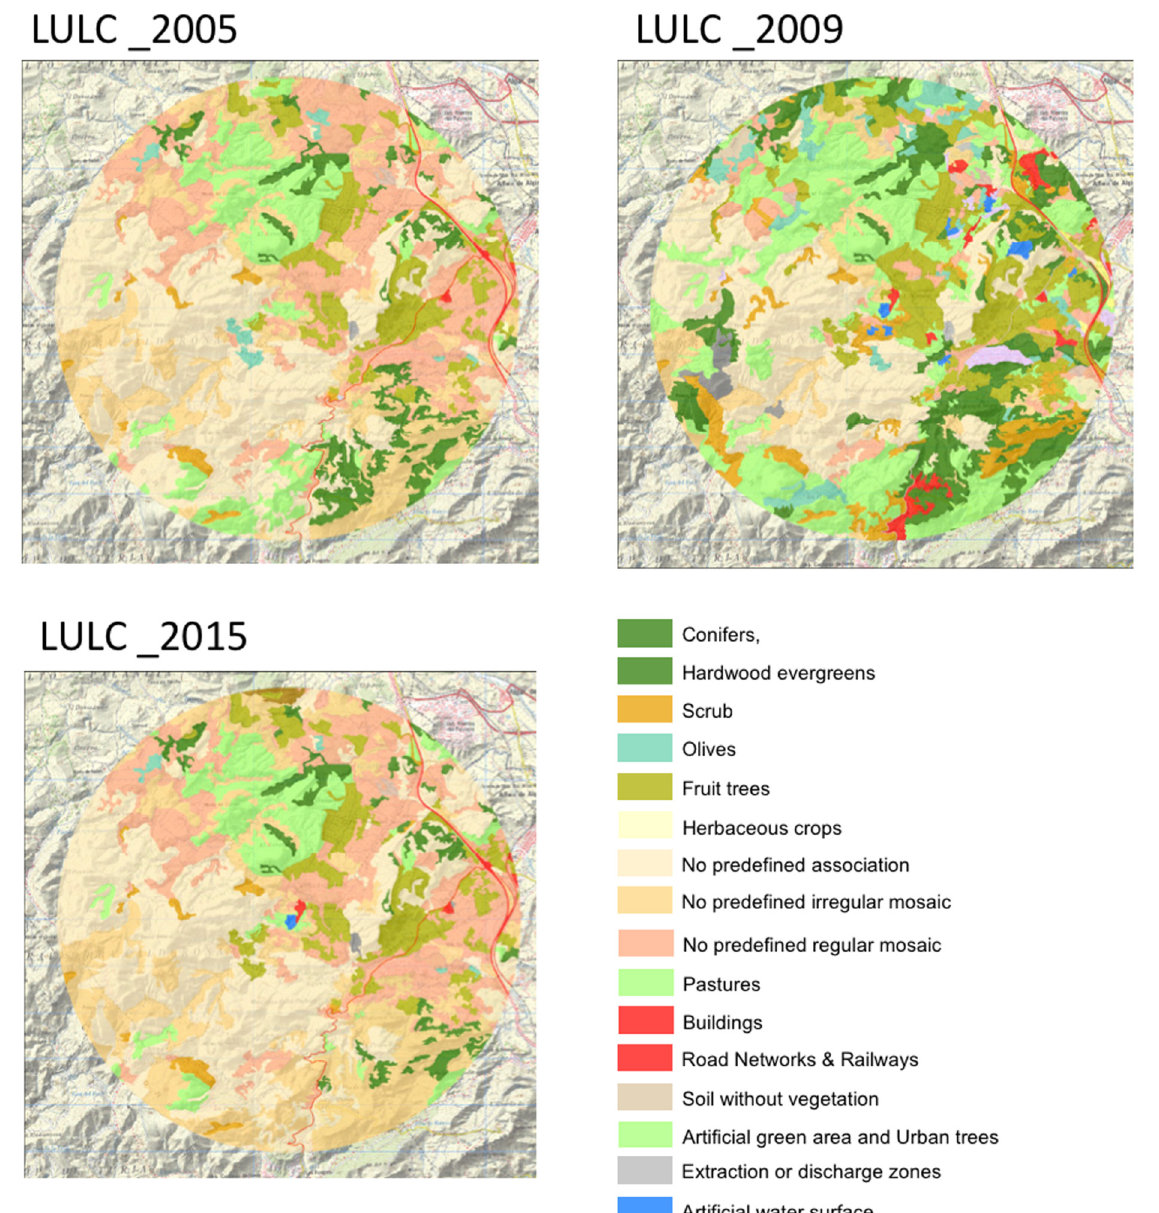
Figure 3. Land use following SIOSE on the Algimia de Alfara landfill influence area in 2005, 2009 and